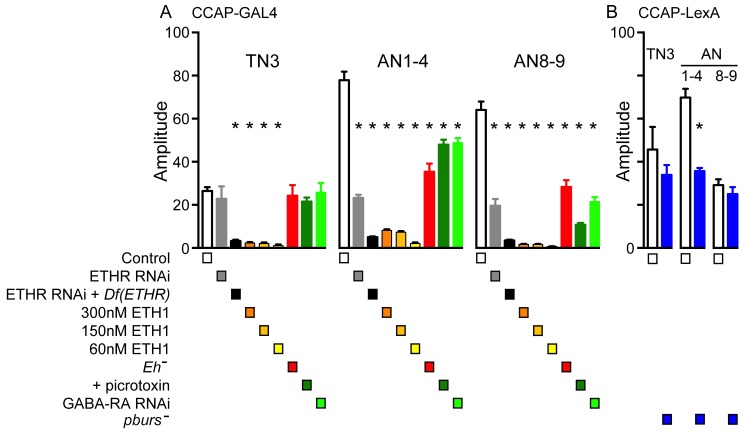
Amplitude of GCaMP response induced by ETH in CCAP neurons.Quantitation of mean amplitude of GCaMP response to ETH of CCAP neurons in TN3, AN1-4, and AN8-9 for different genotypes and conditions (Note: some of the results shown in this figure relate to data shown in Figures 4, 5, and 7). (A) Results obtained for genotypes that used Ccap-GAL4 to drive GCaMP expression. (B) Results obtained for genotypes involving pburs mutants, for which Ccap-LexA was used to drive GCaMP expression (see Figure 6 for further details). N = 6–13 for all conditions. Data are mean ± SEM. One-way ANOVA, followed by Dunnett's post-hoc analyses to control (A) or unpaired two-tailed t test to control (B); ‘*’ p<0.05. Actual p values for all analyses can be found in Supplementary file 1. All animals expressed Ccap-GAL4+GCaMP (A) or Ccap-LexA+LexAop-GCaMP (B); Df(ETHR)/+ indicates hemizygosity for ETHR; Eh[-]: Eh[-]/Df(3)Eh; pburs[-]: pburs[-]/Df(2)pburs. In all experiments using RNAi, its effectiveness was boosted by including a UAS-dcr2 transgene.